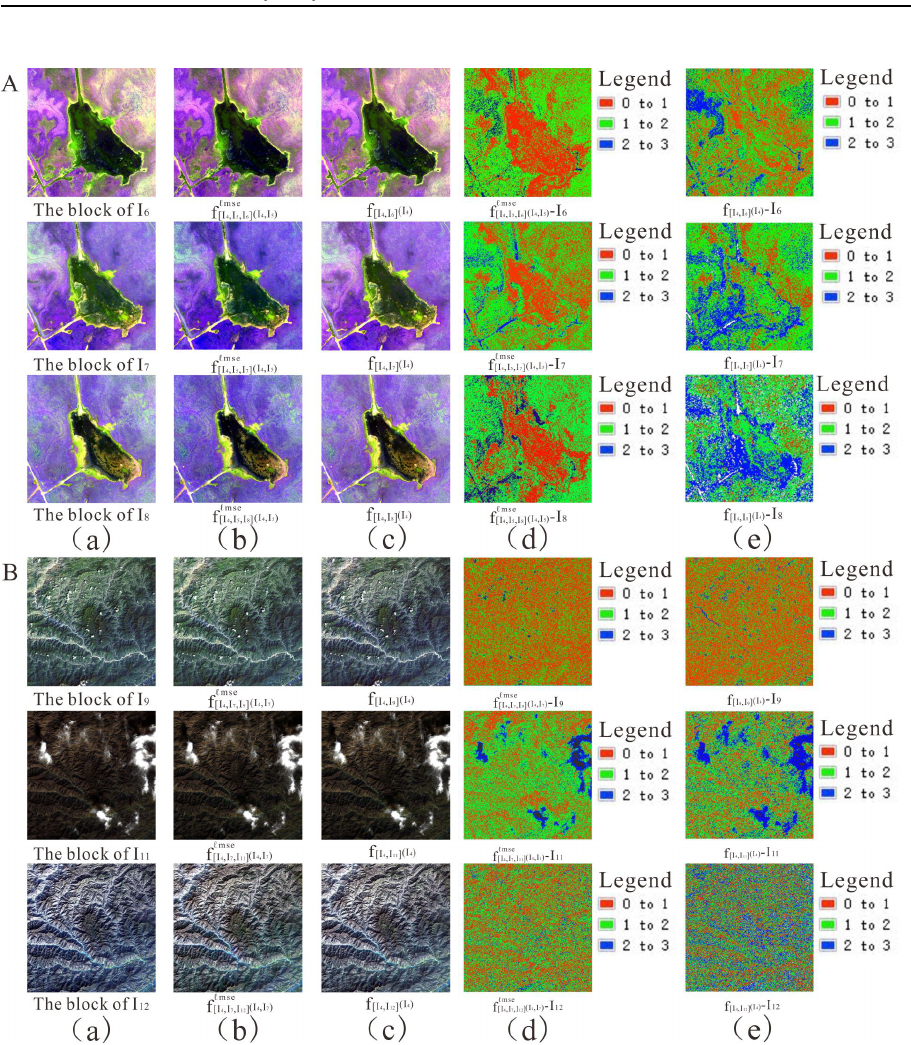
Figure 8. Visual effect and pixel error between block interpolated result and reference block using ( A ) UAV and ( B ) Landsat-8 datasets with ( a ) initial image ( b , d ) our proposed method and ( c , e )